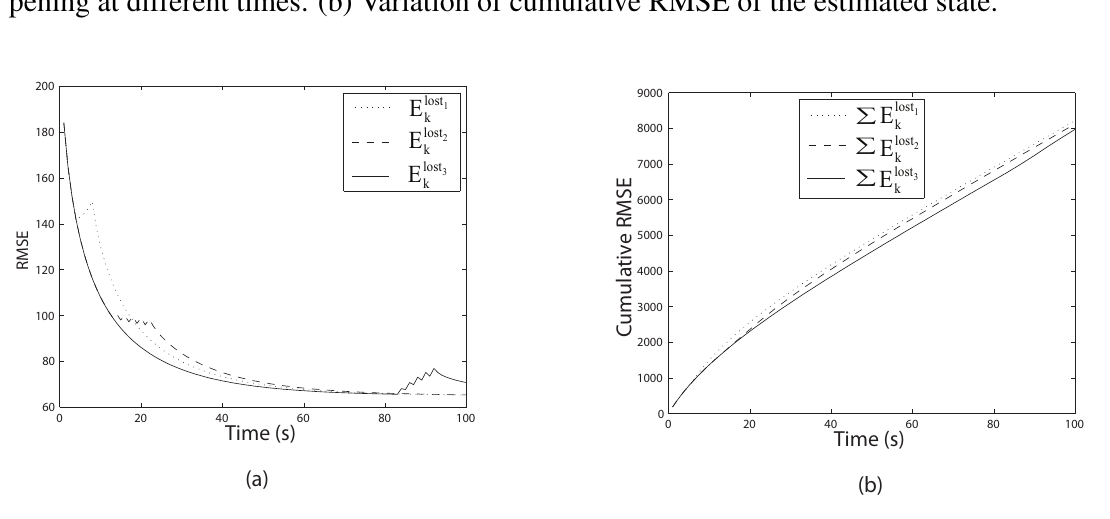
Figure 3. (a) Variation of the RMSE of the estimated state with measurement losses hap- pening at different times. (b) Variation of cumulative RMSE of the estimated